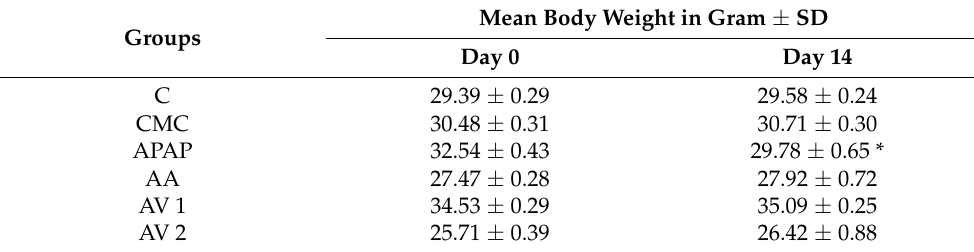
Figure 2. Pearson correlation graphics: ( A ) Pearson correlation between DPPH IC 50 and flavonoids, ( B ) Pearson correlation between DPPH IC 50 and Condensed Tannins, and ( C ) Pearson correlation between DPPH IC 50 and phenols of A. visnaga L. TFC: total flavonoid content; CT: condensed tannins; TPC: total phenolic content; QE: quercetin equivalent. Table 3. Body weight of the mice during the treatment period.